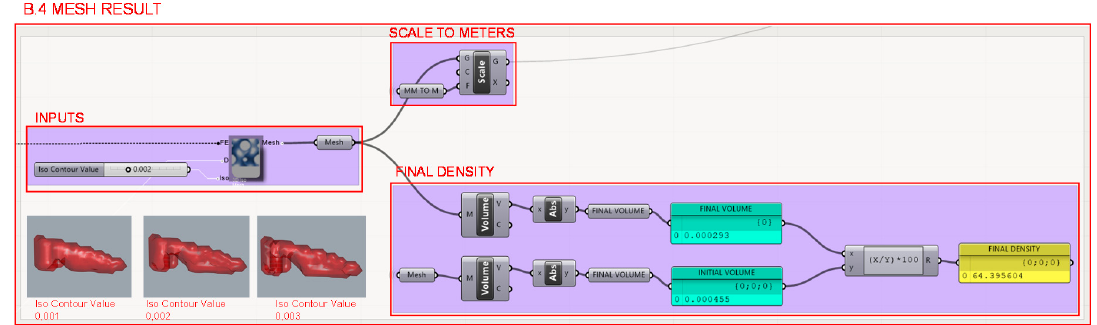
Figure 22. Programming structure definition of the resulting mesh from the topology optimization and its resulting volume percentage with respect to the initial volume.